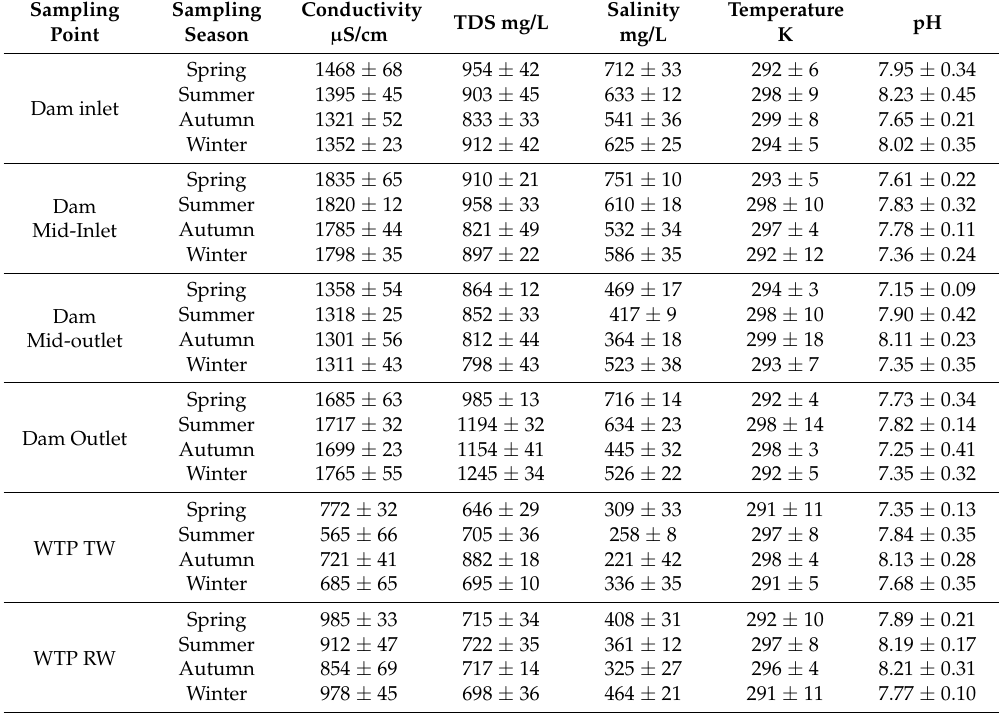
Table 2. The physicochemical indicators of the water quality in the Nandoni Dam (conductivity, TDS, salinity, temperature, and pH) for the water samples collected in spring and summer 2016, autumn and winter